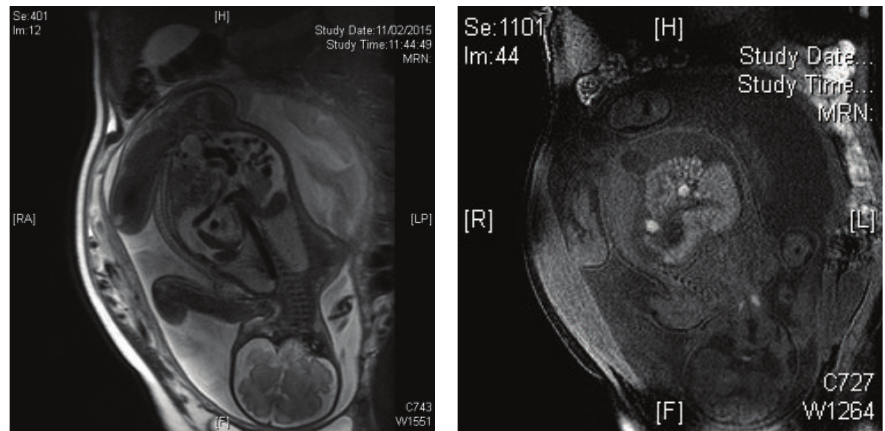
Figure 1: Fetal pelvic MRI showed T1 and T2 isointense soft tissue mass.